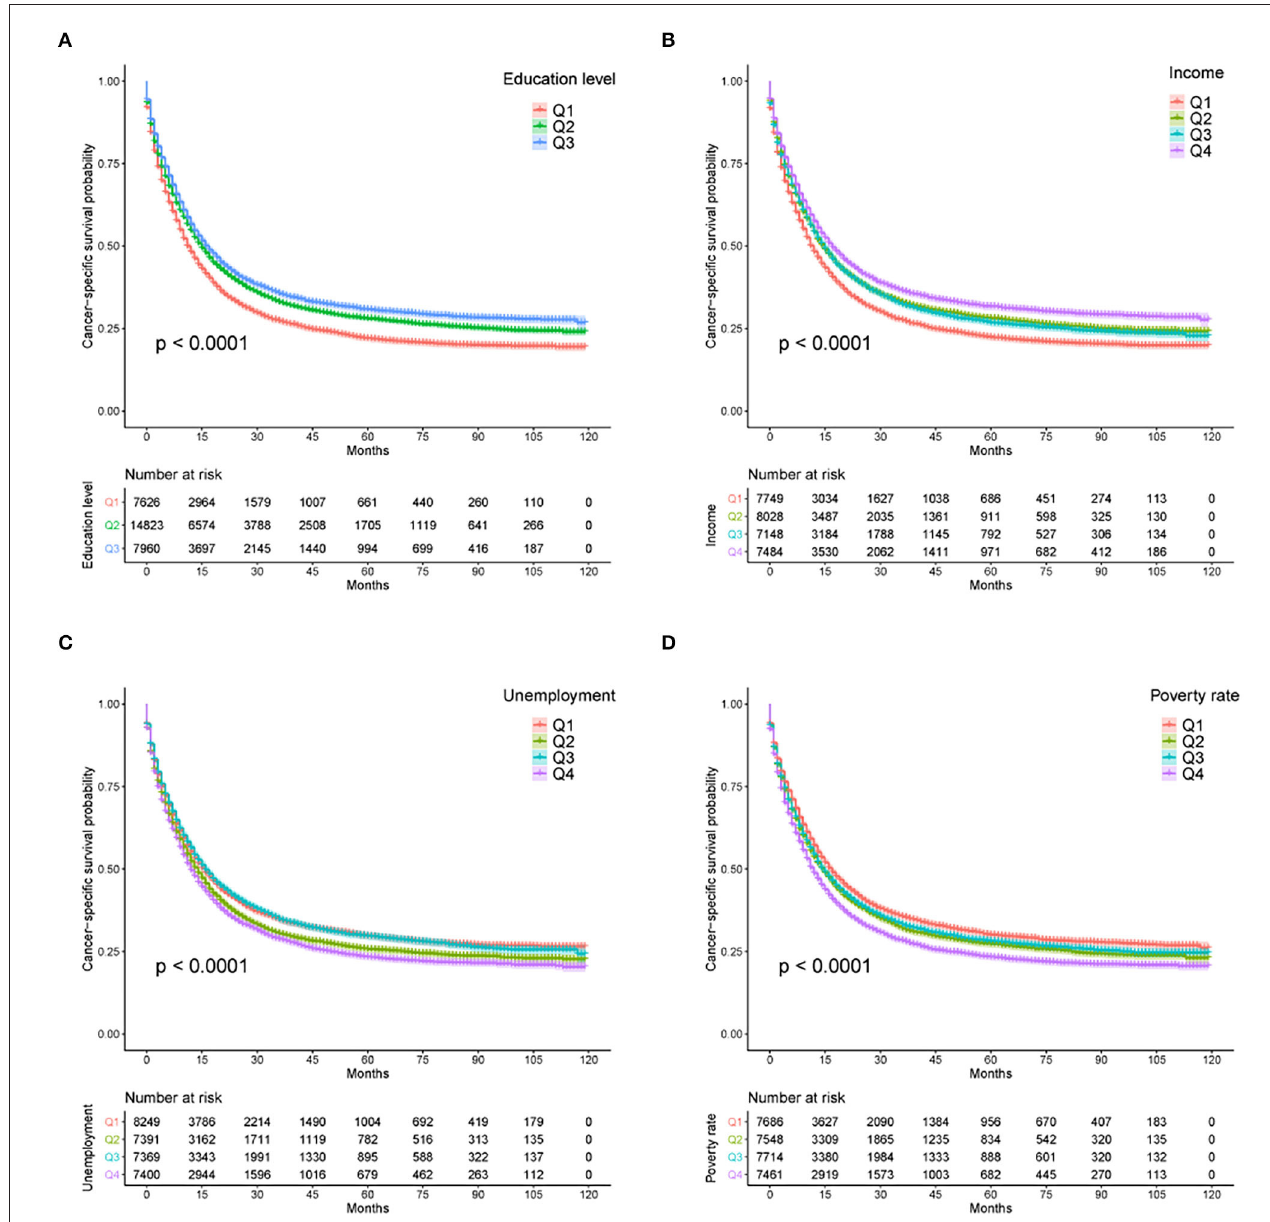
FIGURE 3 | Kaplan–Meier survival curves for CSS according to (A) education level, (B) income, (C) unemployment rate, and (D) poverty rate. CSS, cancer-specific survival; U/M, uninsured/Medicaid; NHW, non-Hispanic White; NHB, non-Hispanic Black; NHAPI, non-Hispanic Asian or Pacific